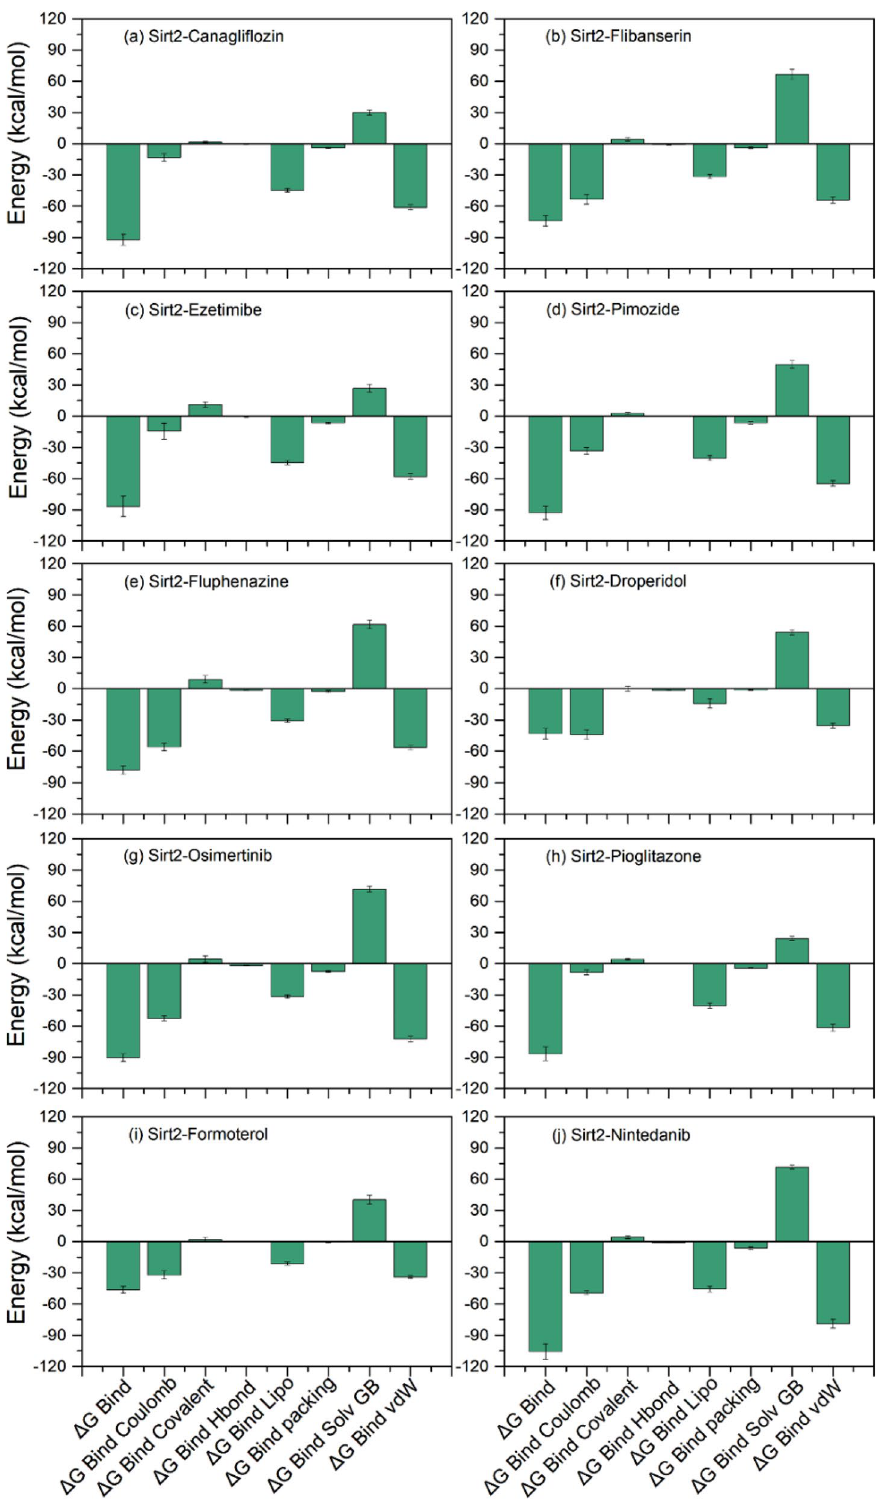
Figure 9. End-point binding free energy (kcal/mol) and dissociation energy components values computed for extracted snapshots of Sirt2 with screened FDA-approved drugs, i.e., ( a ) Canagliflozin, ( b ) Flibanserin, ( c ) Ezetimibe, ( d ) Pimozide, ( e ) Fluphenazine, ( f ) Droperidol, ( g ) Osimertinib, ( h ) Pioglitazone, ( i ) Formoterol, and ( j ) Nintedanib, from respective 100 ns MD simulation